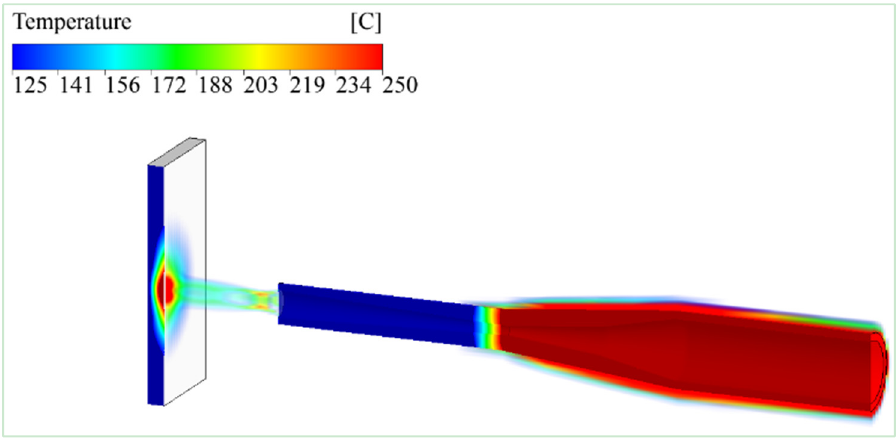
Figure 6. Holistic estimation of temperature from gas injection point to the titanium substrate surface for cold spray conditions 550 °C and 1.4 MPa, using calibrated 3D multicomponent